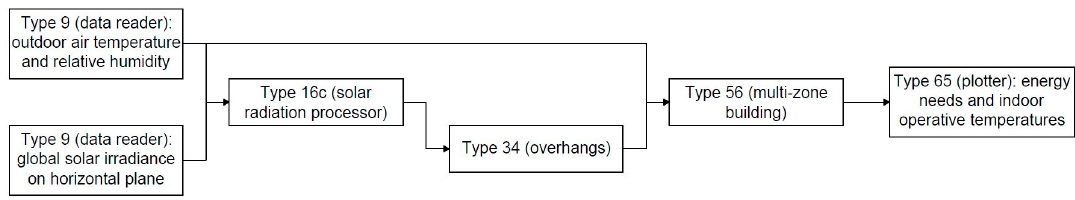
Figure 1. TRaNsient SYstem Simulation (TRNSYS) model flowchart.